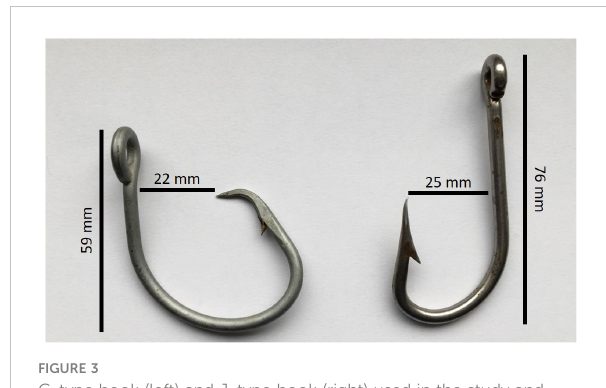
FIGURE 3 C-type hook (left) and J-type hook (right) used in the study and their